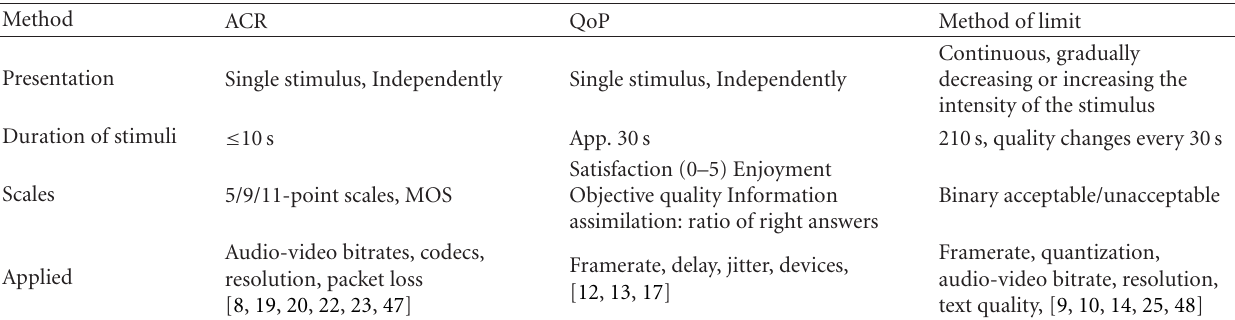
Table 1: Overview to overall quality evaluation